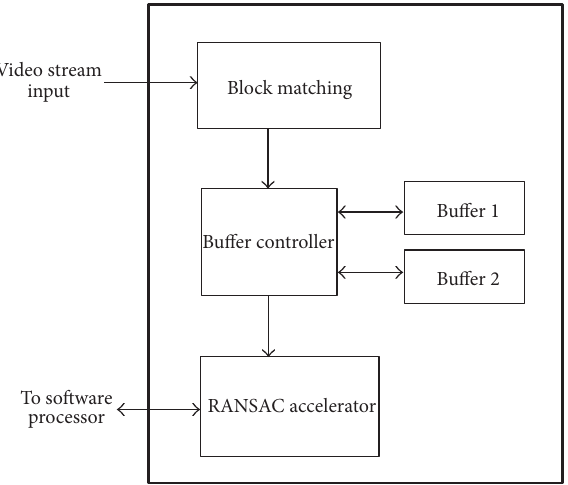
Figure 5: Hardware architecture of motion estimation